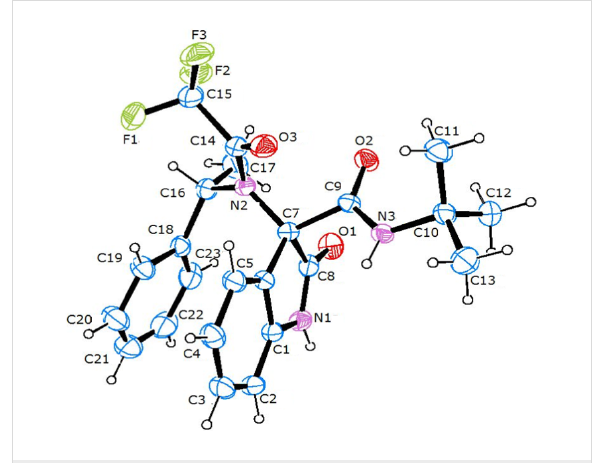
Figure 2: ORTEP [37] view of one of the two independent molecules of 4a present in the asymmetric unit, showing the arbitrary atom- labelling scheme. Atomic displacement parameters for non-H atoms are at a probability level of